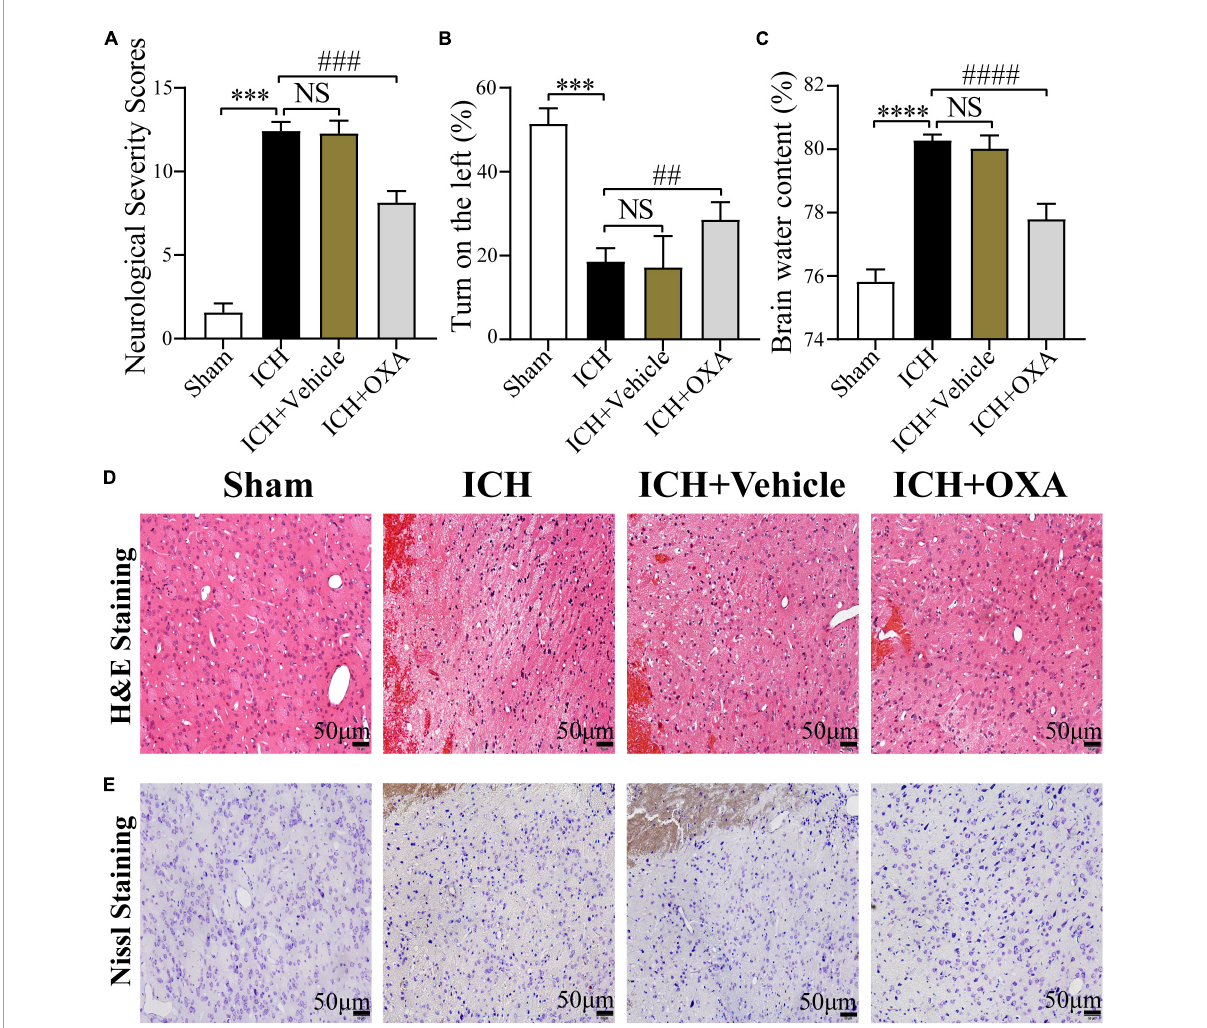
FIGURE1 Orexin-A alleviates early brain injury following ICH in vivo . (A) Modified neurological severity scores (mNSS) and (B) corner turn test showed that neurological function was significantly impaired after ICH, and OXA treatment significantly improved outcomes. (C) Water content of brain tissues in each group. ∗∗∗ p < 0.001 and ∗∗∗∗ p < 0.0001 vs. the sham group; NS, non-significant different compared to the ICH group. ## p < 0.01, ### p < 0.001 and #### p < 0.0001 vs. the ICH group. (D,E) Representative images of H&E and Nissl staining in the perihematomal brain tissues region. Scale bar, 50 µ